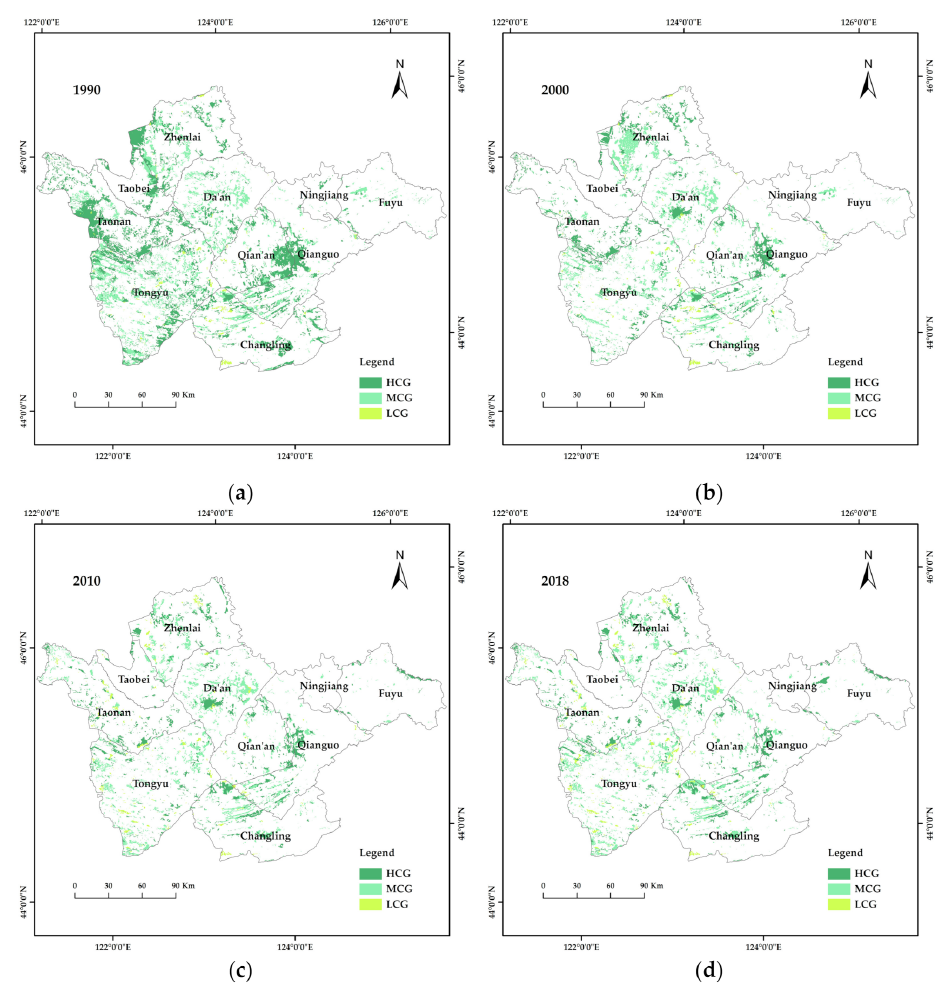
Figure 2. Grassland distribution in western Jilin Province from 1990 to 2018. HCG, High-cover grassland; MCG, Medium-cover grassland; LCG, Low-cover grassland. ( a – d ), spatial distribution of high, medium and low cover grassland in western Jilin province in 1990, 2000, 2010 and 2018,